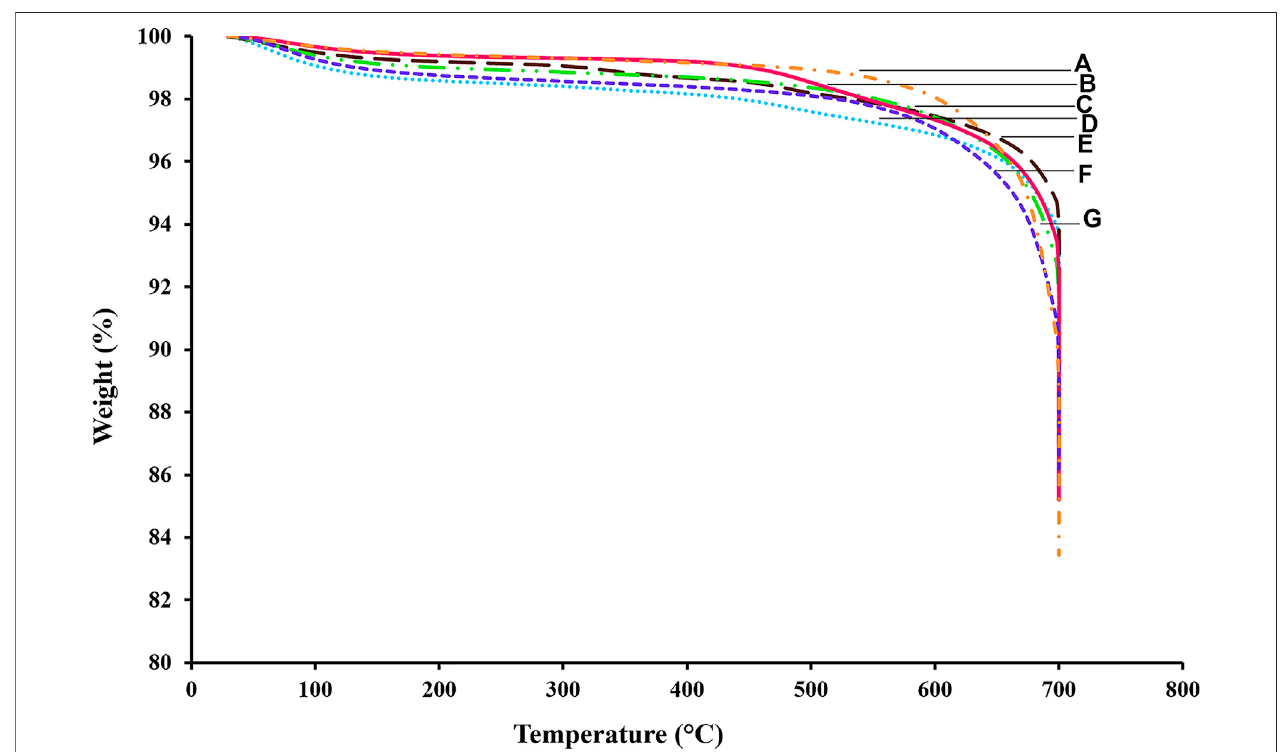
FIGURE2| TGApro fi lesofOCP f -supportedNiMocatalysts (A) 5.0wt%Ni19wt%Mo/OCP f (B) 3.5wt%Ni19wt%Mo/OCP f (C) 3.5wt%Ni13wt%Mo/OCP f (D) 2.5wt